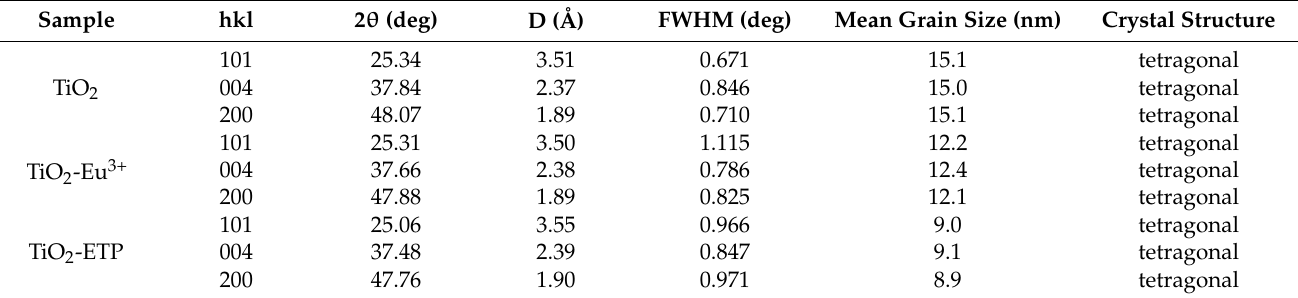
Table 1. XRD results with parameters.